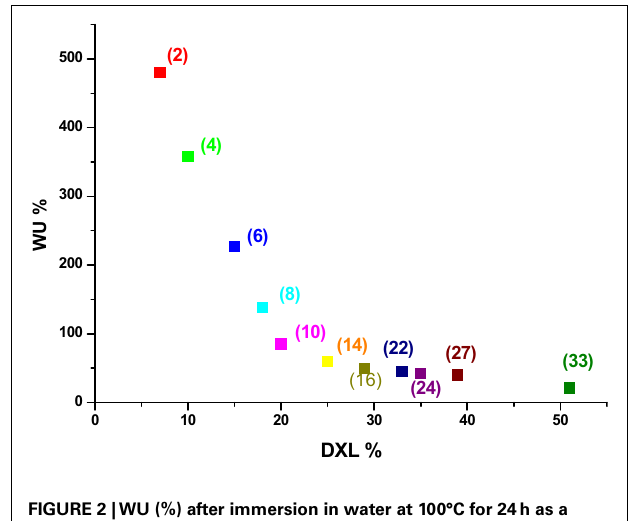
FIGURE 2 |WU (%) after immersion in water at 100°C for 24h as a function of DXL for a SPEEK sample with an initial IEC = 2.5meq/g . In parenthesis, the time of the second treatment at 180°C is